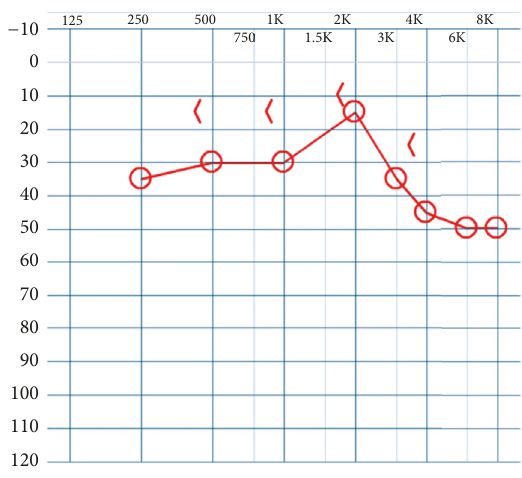
Figure 3: Postoperative pure tone audiometry revealed improve- ment of the air conduction thresholds to a mild conductive hearing losswithnearclosureoftheair-bonegapontheright.Unfortunately, the patient has not followed up for postoperative audiogram after his second operation but reports subjectively improved and symmetric